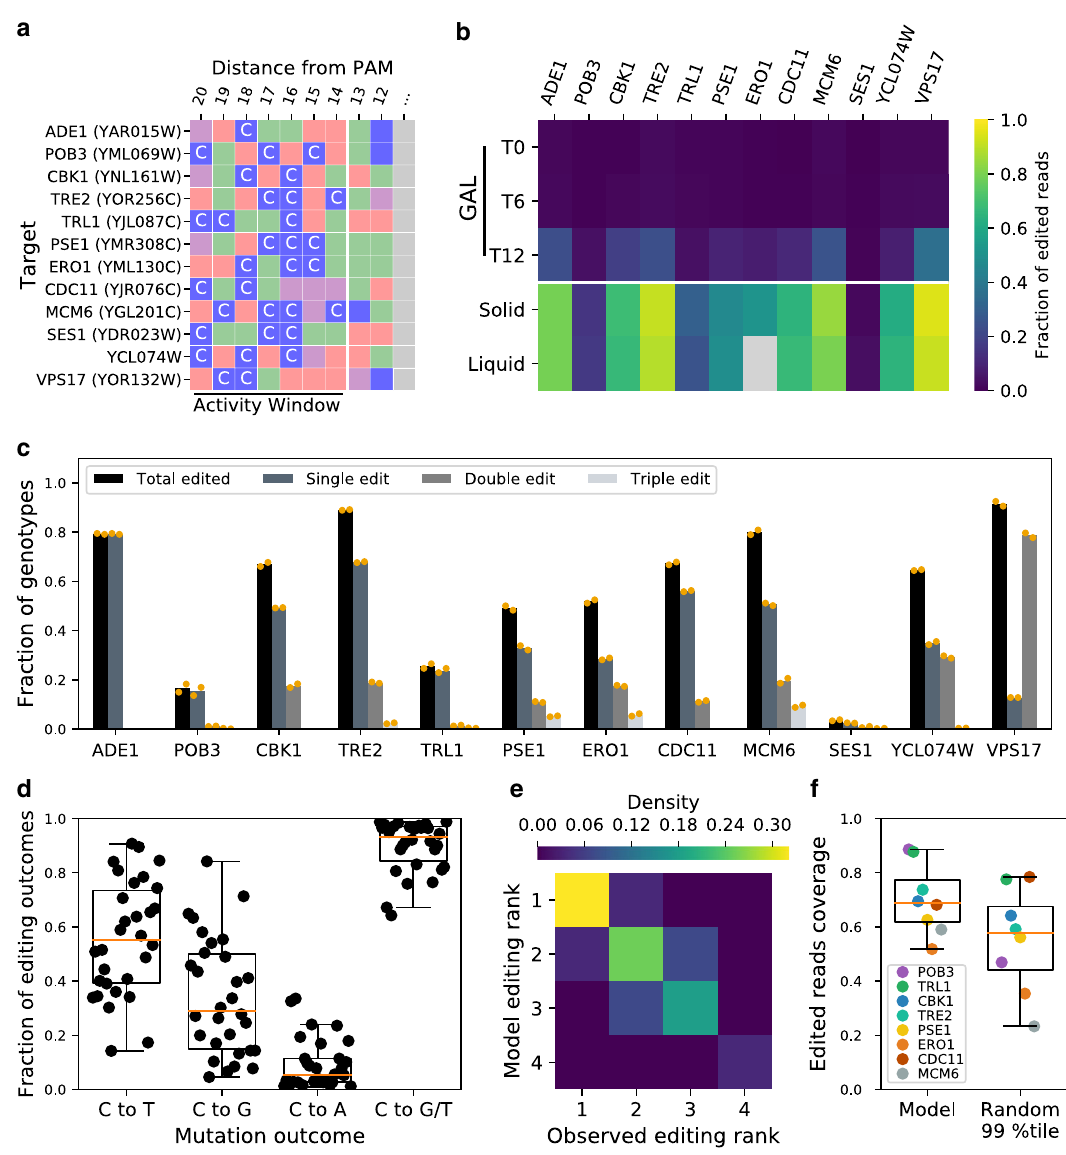
Fig. 1 A parsimonious model predicts the most probable outcomes of Target-AID mutagenesis. a gRNAs included in the time course base editing experiment had diverse C content pro fi les in the Target-AID activity window. Nucleotides are color coded: guanines are purple, thymines are red, adenines are green and cytosines are blue. b Overall fraction of edited reads for all target sites along time points in the experiment: T0 (start of induction), T6 (mid induction), T12 (end of induction). The solid time point represents surviving cells plated after galactose induction, while the liquid time point represents the cell population after canavanine co-selection. Ampli fi cation of the ERO1 target site from the liquid recovery time points was unsuccessful (shown in gray), and as such the solid recovery time point was used instead for the other analysis steps. c Fraction of genotypes with either one, two or three edits compared to the total fraction of reads that were edited. d Editing outcome type for all sites with a total editing rate greater than one percent after co- selection ( n = 30 cytosines across all targeted sites). The C to G/T distribution represents the sum of editing that resulted in a C to G or C to T mutation. Position-wise editing rates and outcomes are shown in Supplementary Figs. 5 and 6. e Agreement between the predicted nucleotide total editing rank in the model used to predict mutagenesis outcomes in the large-scale experiment and the deep sequencing data ( n = 28 sites, 10 gRNAs: gRNA speci fi c predicted and observed rankings are presented in Supplementary Figs. 5 and 6). The gRNAs targeting ADE1 and SES1 were respectively excluded from the analysis because there is only one editable site in the activity window and total editing rate was too low. f Edited read coverage of the mutation outcome prediction model and the 99th percentile of edited allele combinations ( n = 4 genotypes in both cases) for the gRNAs with editing activity included in the large-scale experiment. Boxplots represent the upper and lower quartiles of the data, with the median shown as a yellow bar. Whiskers extend to 1.5 times the interquartile range (Q3 – Q1) at most. Source data are available in the Source Data fi